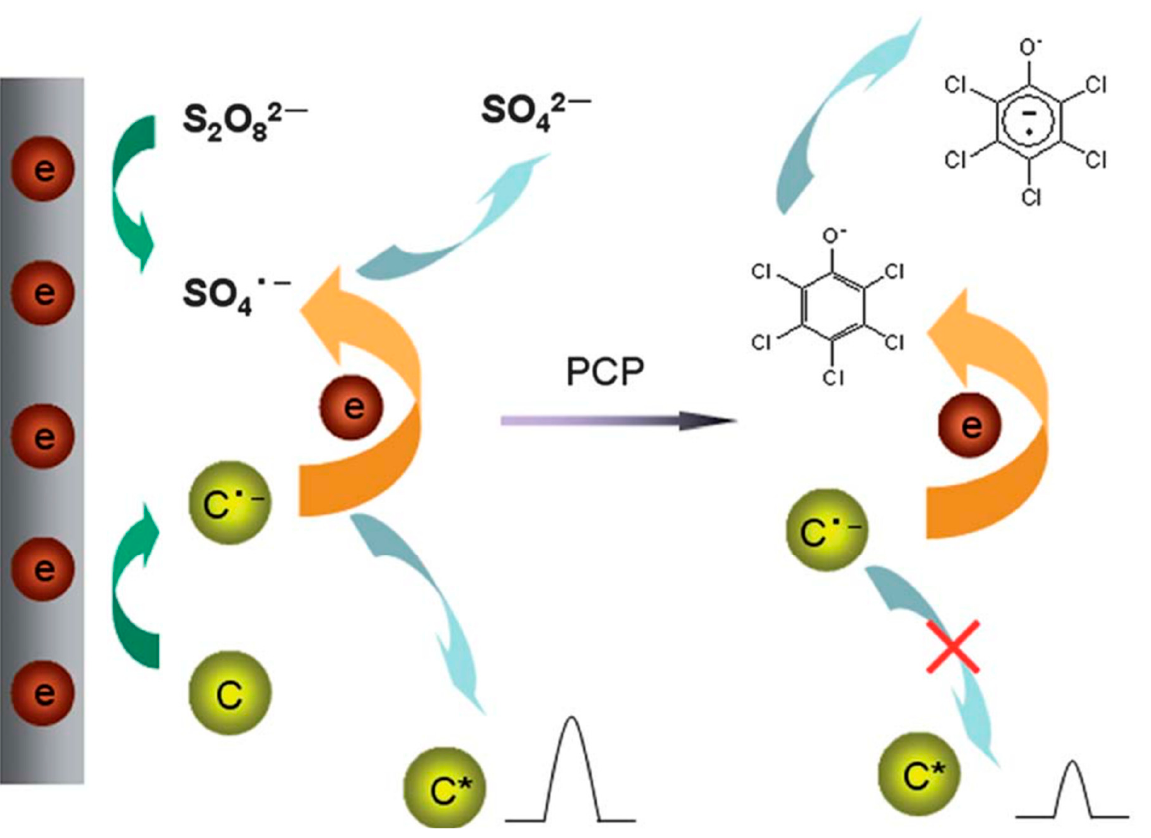
Figure 8. Schematic showing the ECL detection of pentachlorophenol by using CQDs in S 2 O 82 − solution (Adapted from the Ref. [196] with the permission of ACS).